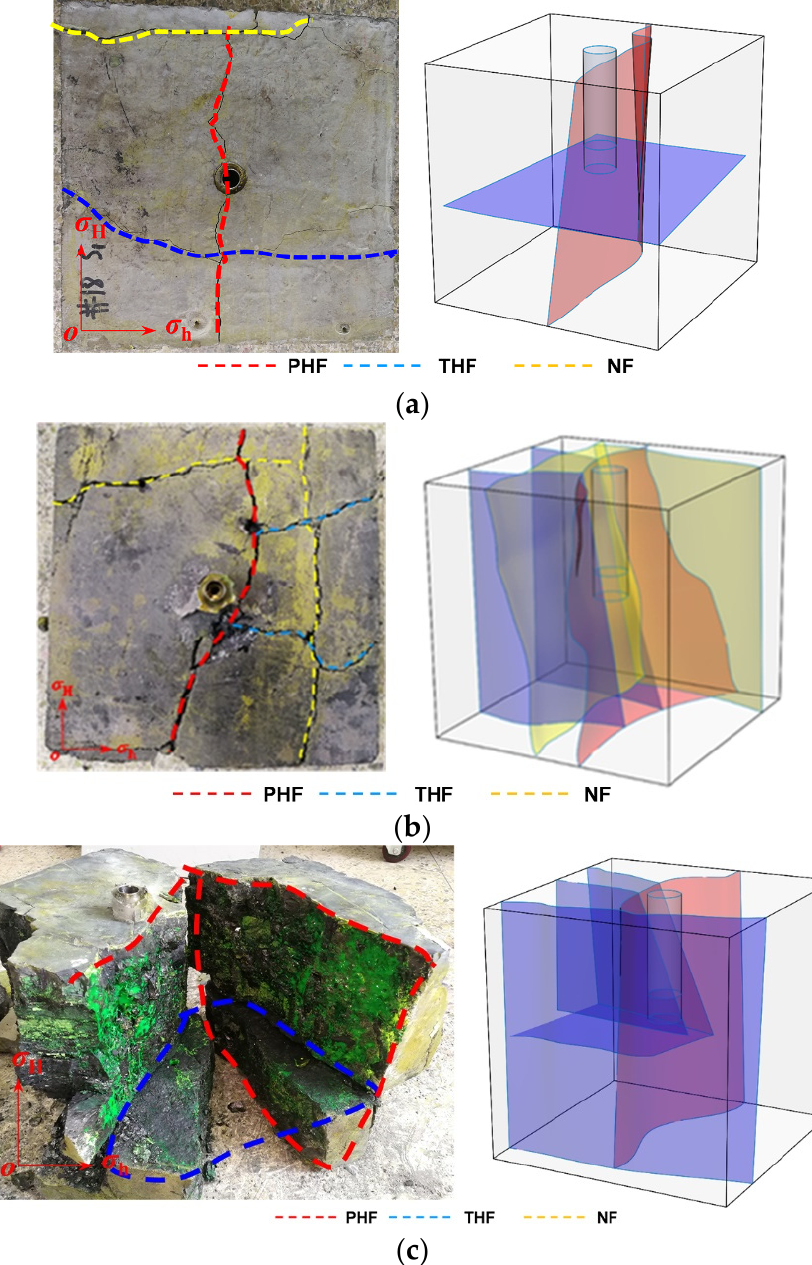
Figure 9. Effect of the particle size of TPA on fracture geometry: ( a ) fracture morphology of sample 6#; ( b ) fracture morphology of sample 2#; ( c ) fracture morphology of sample 7#.